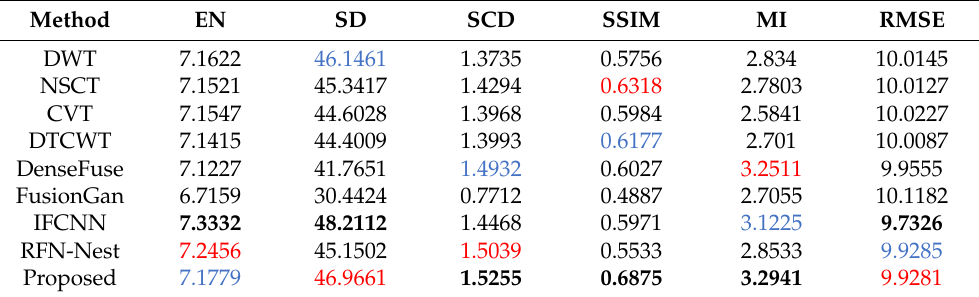
Table 7. Quantitative results on 50 pairs of images from LLVIP dataset. The best values, the second- best values and the third-best values are indicated in bold, red and blue,